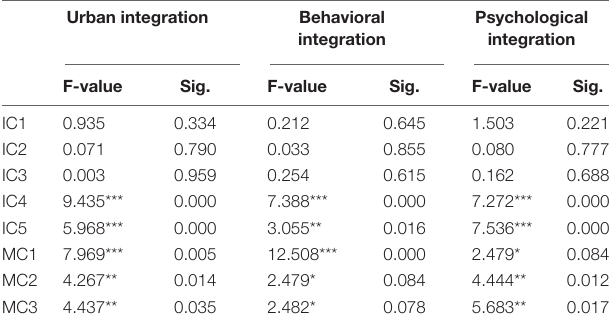
TABLE 5 | Summary of one-way analysis of variance